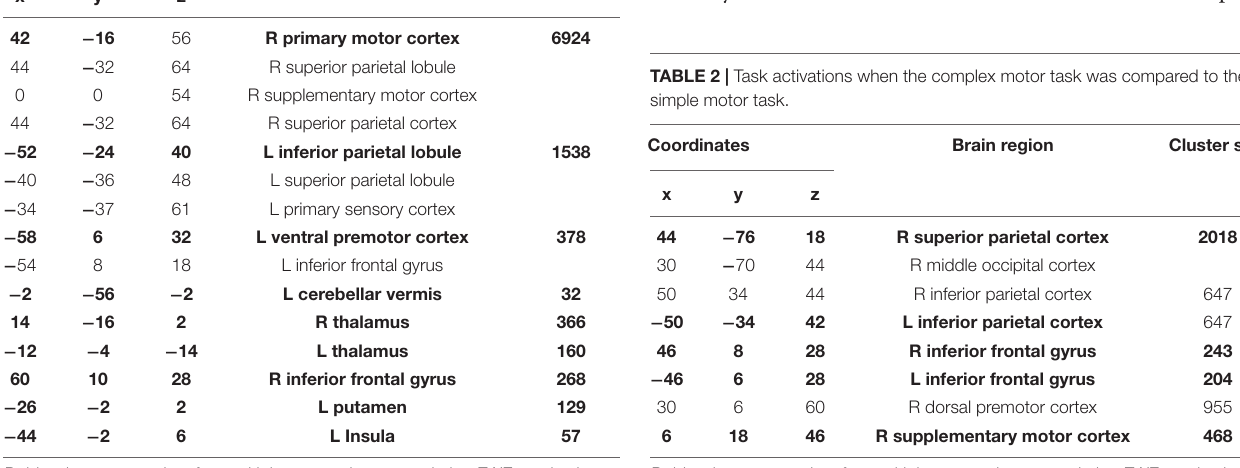
Bold values: correction for multiple comparisons used the FWE method at a corrected p < 0.05. Cluster size is indicated in